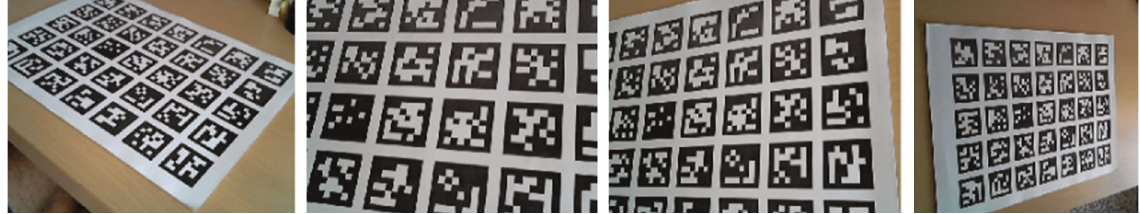
Figure 2: Di ff erent viewpoints of a ChArUco calibration prop/object. Depending on the location and con fi guration of each sensor with respect to the monitoring area, one needs to ensure that each sensor has an unambiguous view of the calibration prop. For all the experiments associated with this paper, the physical size of the marker is adjusted, and its placement is con fi gured with respect to the common viewing angles of all of the sensors in order to ensure accurate calibration results. The fi gure shows four typical views of the common calibration object with respect to the